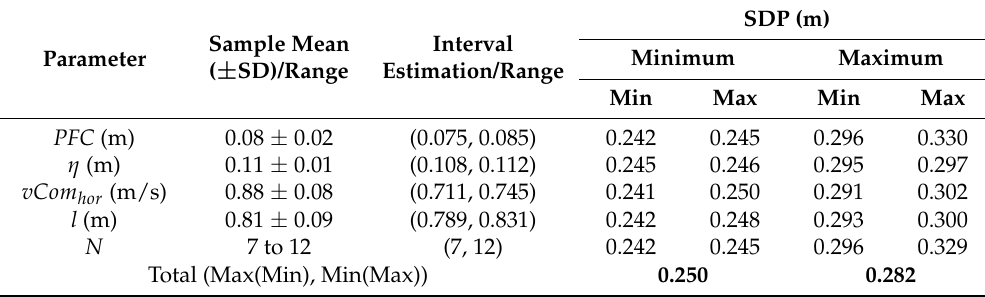
Table 5. The floating range of parameters and the design range of